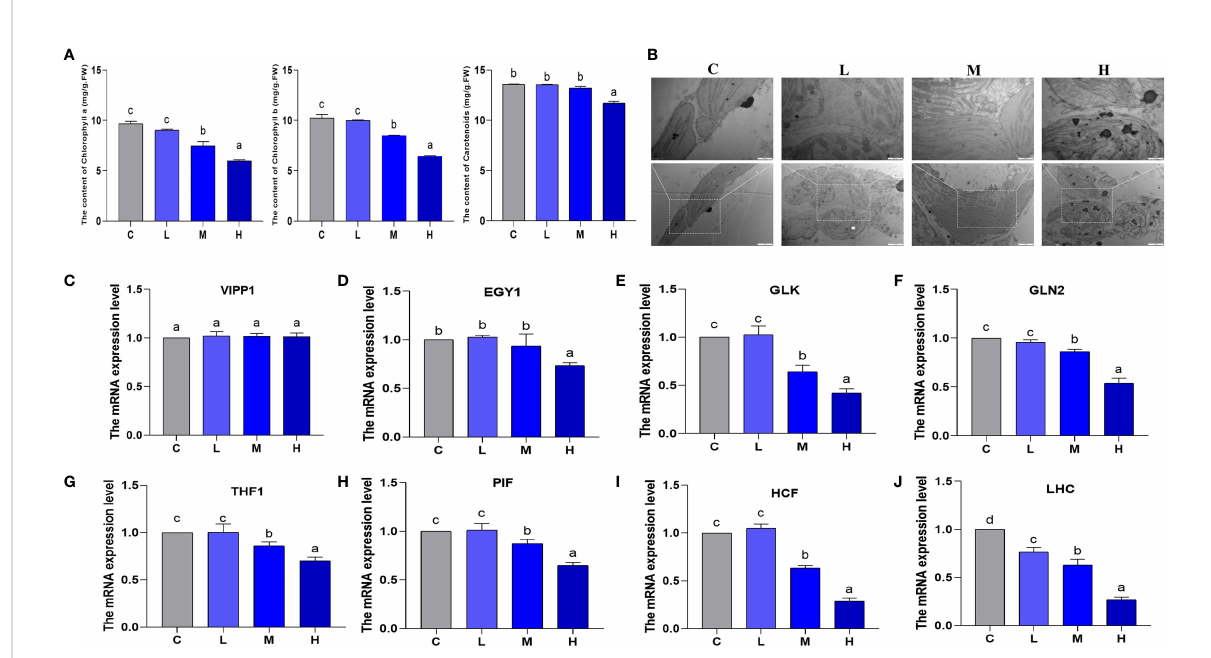
FIGURE 6 The effect of Pb stress on the chlorophyll content and chloroplast formation of pakchoi. (A) The content of chlorophyll a, chlorophyll b, and carotenoids in pakchoi leaves (45 d) (n=3). (B) Observation on the ultrastructure of chloroplasts in pakchoi leaves (n=3). Scale: 20 × (1 µm), 40 × (500 nm). (C) qRT-PCR analysis of VIPP1 mRNA level in pakchoi leaves (45 d) (n=3). (D) qRT-PCR analysis of EGY1 mRNA level in pakchoi leaves (45 d) (n=3). (E) qRT-PCR analysis of GLK mRNA level in pakchoi leaves (45 d) (n=3). (F) qRT-PCR analysis of GLN2 mRNA level in pakchoi leaves (45 d) (n=3). (G) qRT-PCR analysis of THF1 mRNA level in pakchoi leaves (45 d) (n=3). (H) qRT-PCR analysis of PIF mRNA level in pakchoi leaves (45 d) (n=3). (I) qRT-PCR analysis of HCF mRNA level in pakchoi leaves (45 d) (n=3). (J) qRT-PCR analysis of GLDH mRNA level in pakchoi leaves (45 d) (n=3). The same letter indicates no signi fi cant difference (P > 0.05); completely different letter indicates signi fi cant difference (P <